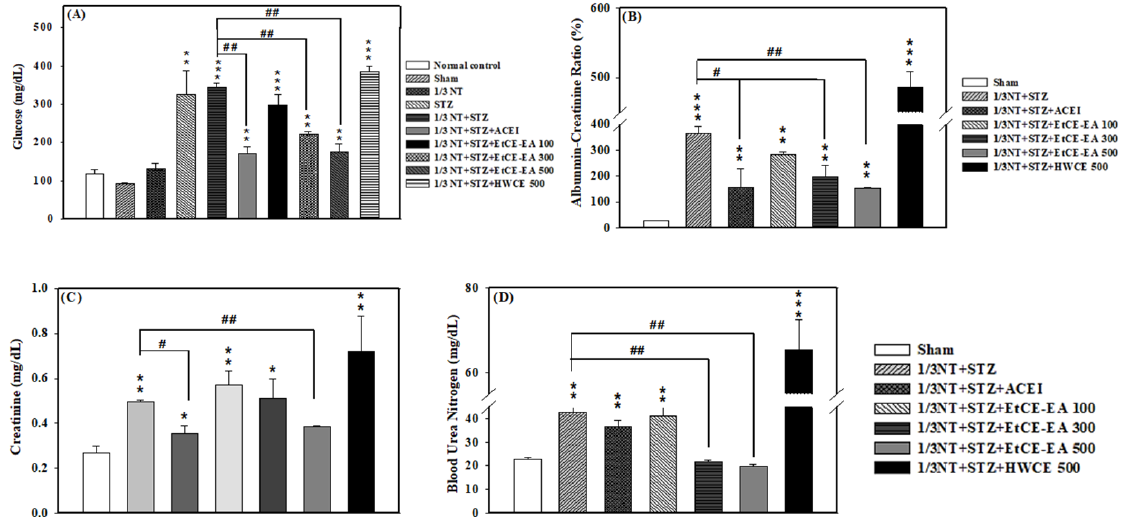
Figure 4. Blood samples were collected from the retro-orbital sinus of CRF mice in each group. ( A ) The fasting blood glucose test, ( B ) Urine albumin-creatinine ratio (ACR), ( C ) Creatinine blood test, and ( D ) Blood urea nitrogen (BUN) levels were measured at two weeks including 1/3 NT +STZ alone, 1/3 NT + STZ following ACEI (20 mg/kg), EtCE-EA: Ethyl acetate layer after water-ethyl acetate separation from ethanol crude extract (100, 300 and 500 mg/kg) and HWCE: hot water crude extract of Inonotus obliquus fruit bodies (500 mg/kg) treatments as compared to the sham group. Sham: vehicle control; ACEI (Selective ACE Inhibitor); 1/3 NT: residual 2/3 kidney animal model. The data are expressed as mean ± SD of five mice. *: p < 0.05, **: p < 0.01 and ***: p < 0.001 as compared with the sham control at two weeks. #: p < 0.05, ##: p < 0.01 and ###: p < 0.001 as compared with 1/3 NT + STZ alone at the two-week trial.